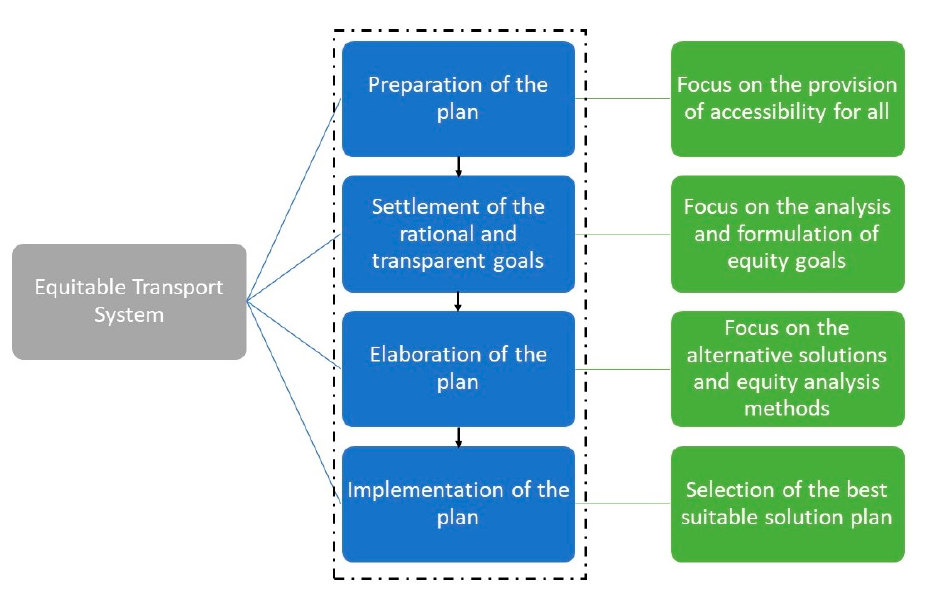
Figure 1. Strategic elements for an equitable mobility planning policy. Source: [26].